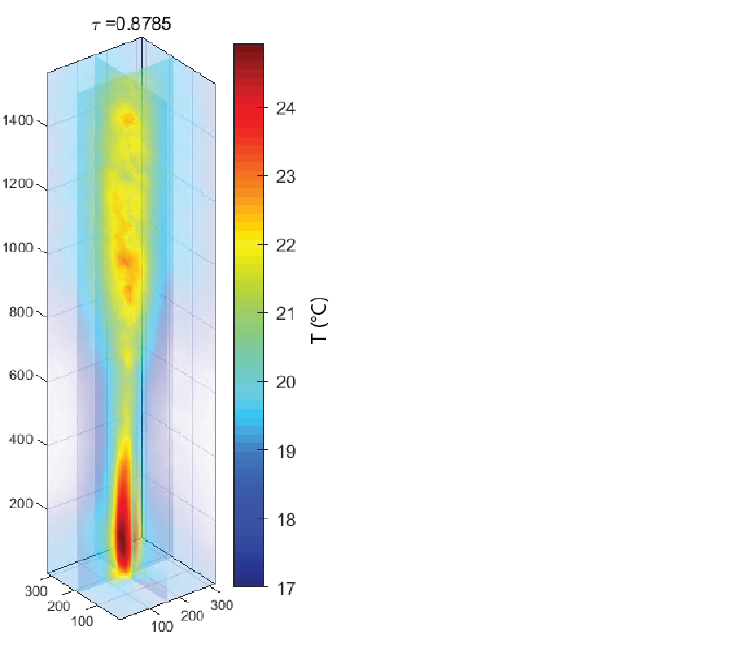
Figure 8. Tomographic reconstruction of the averaged phase profile.